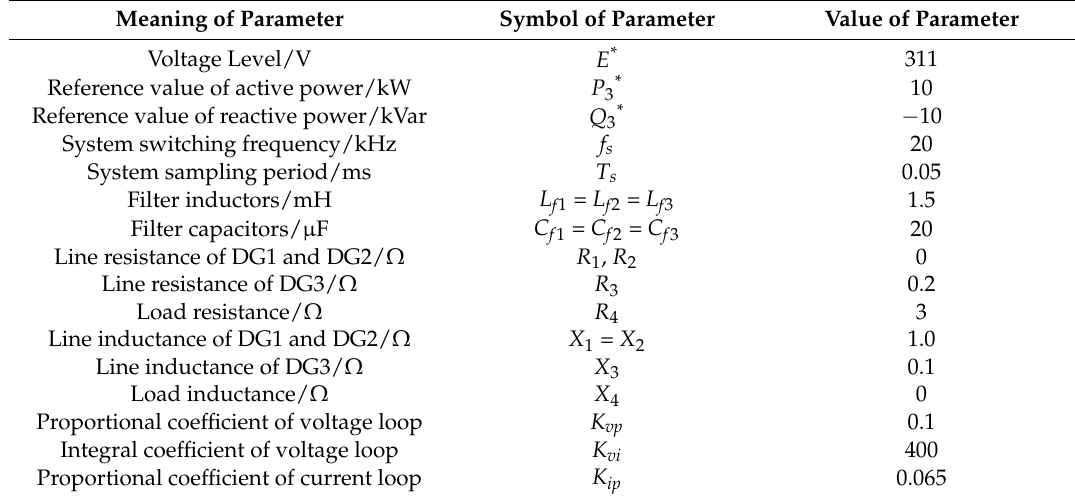
Table A1. System basic parameter